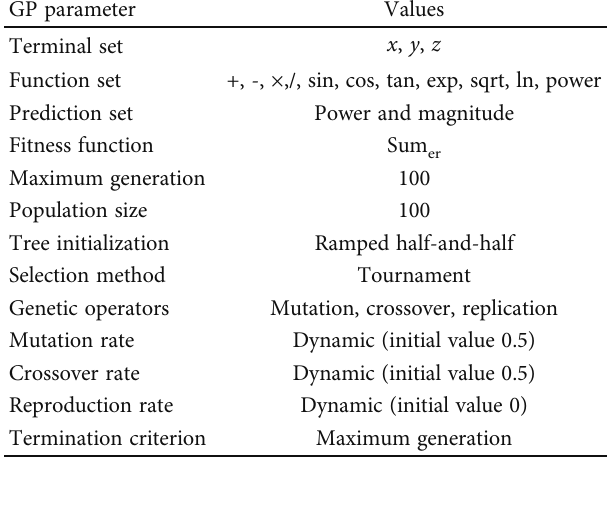
Figure 5: Evolution of operator probabilities and cumulative occurrences.